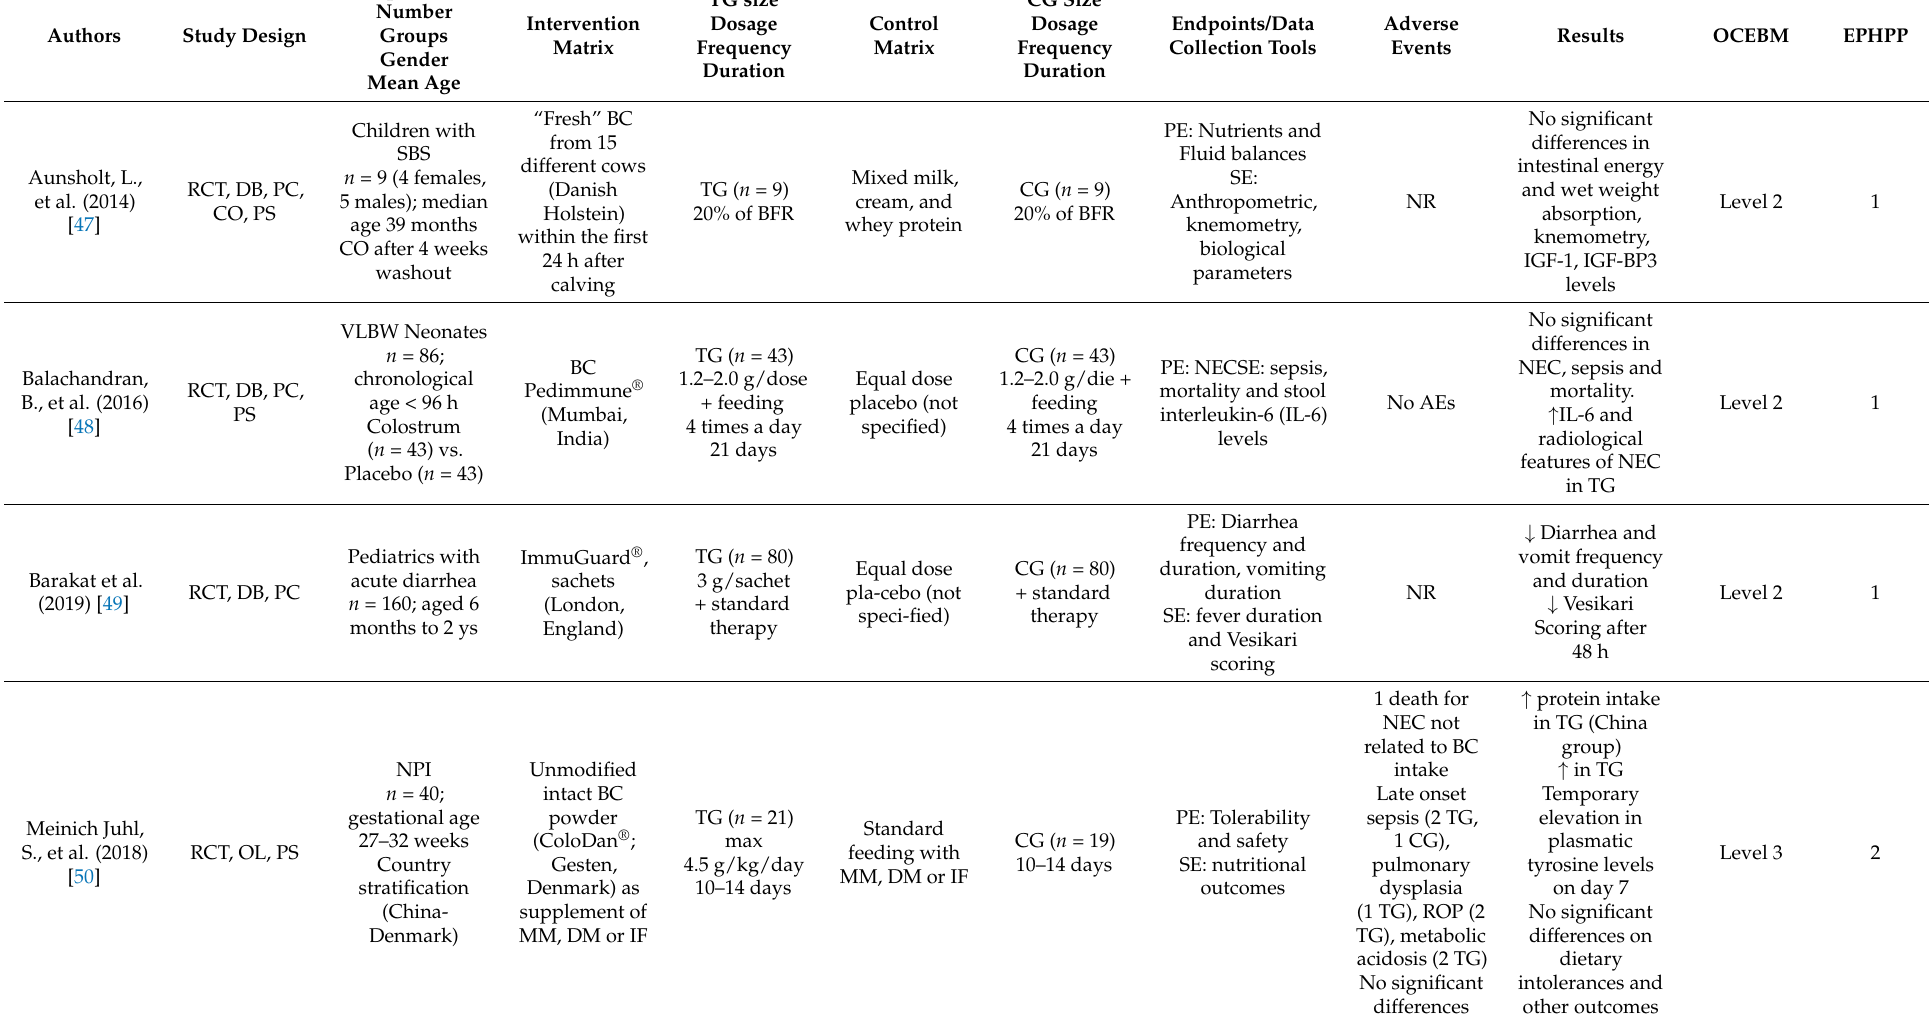
Table 4. BC as dietary supplement in the pediatric and preterm